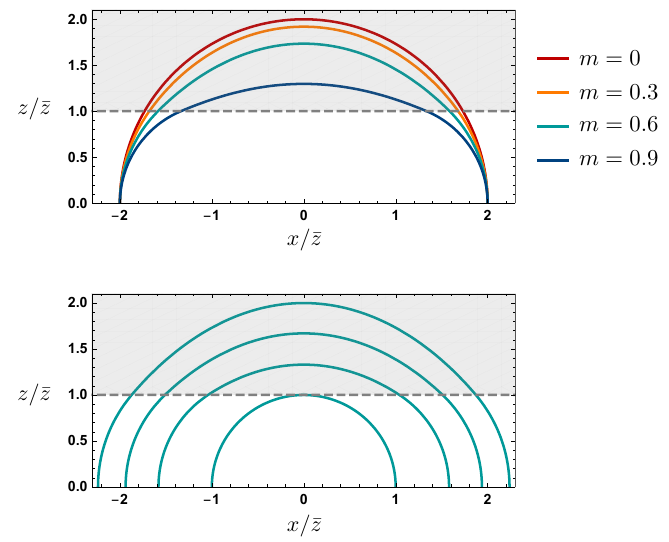
Figure 3 . Illustration of the geodesics whose trajectories are given in eq. (2.45), for a step function dust density m (cid:18) ( z (cid:22) z ) (gray shading). For z < (cid:22) z , the geodesics are the semicircles in ( x; z ) (cid:0) coordinates given in eq. (2.23). Geodesics reaching into the dusty region are increasingly pushed away from the dust for higher and higher dust